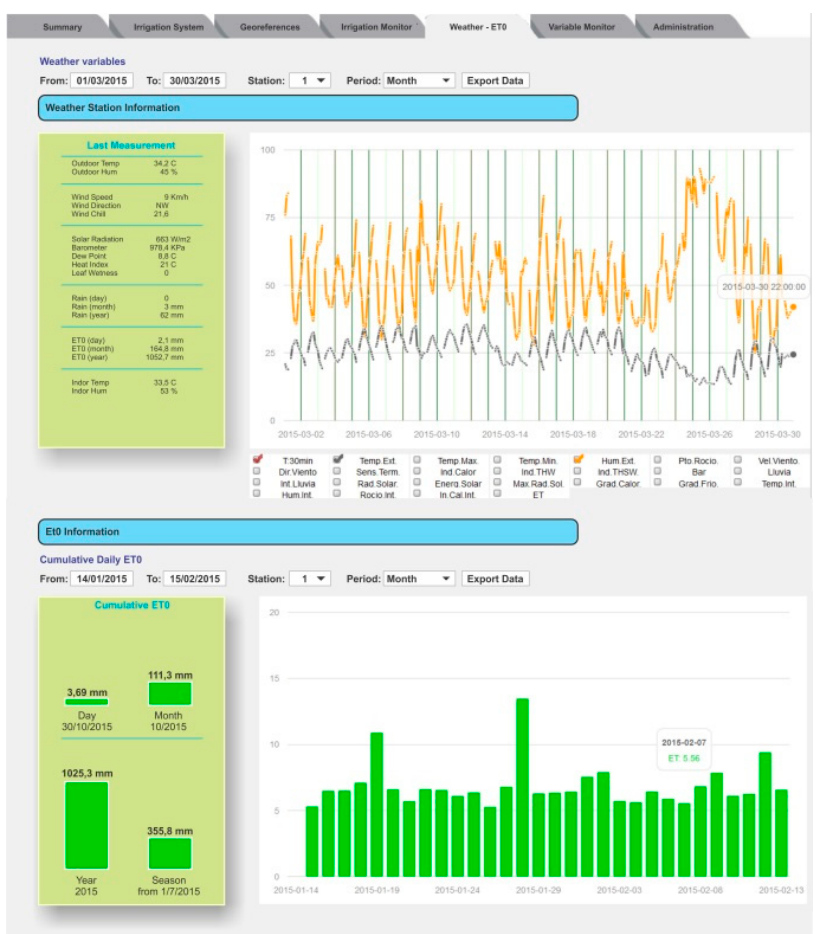
Figure 7. The Weather– (cid:1831)(cid:1846) (cid:2868) tab displays the evolution of the weather variables and the cumulative daily (cid:1831)(cid:1846) (cid:3042) estimation.